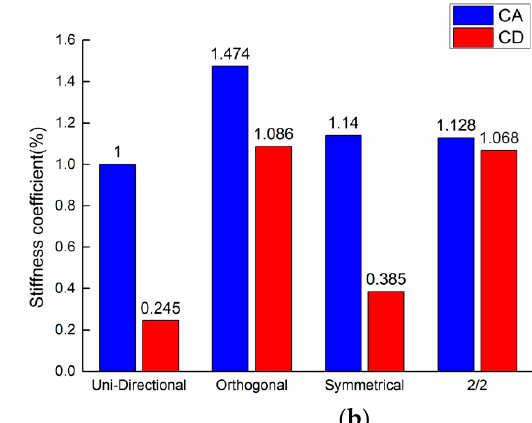
( b ) Figure 12. Comparison of the bending properties of materials with different weft densities. ( a ) Bending strength. ( b ) Bending stiffness.